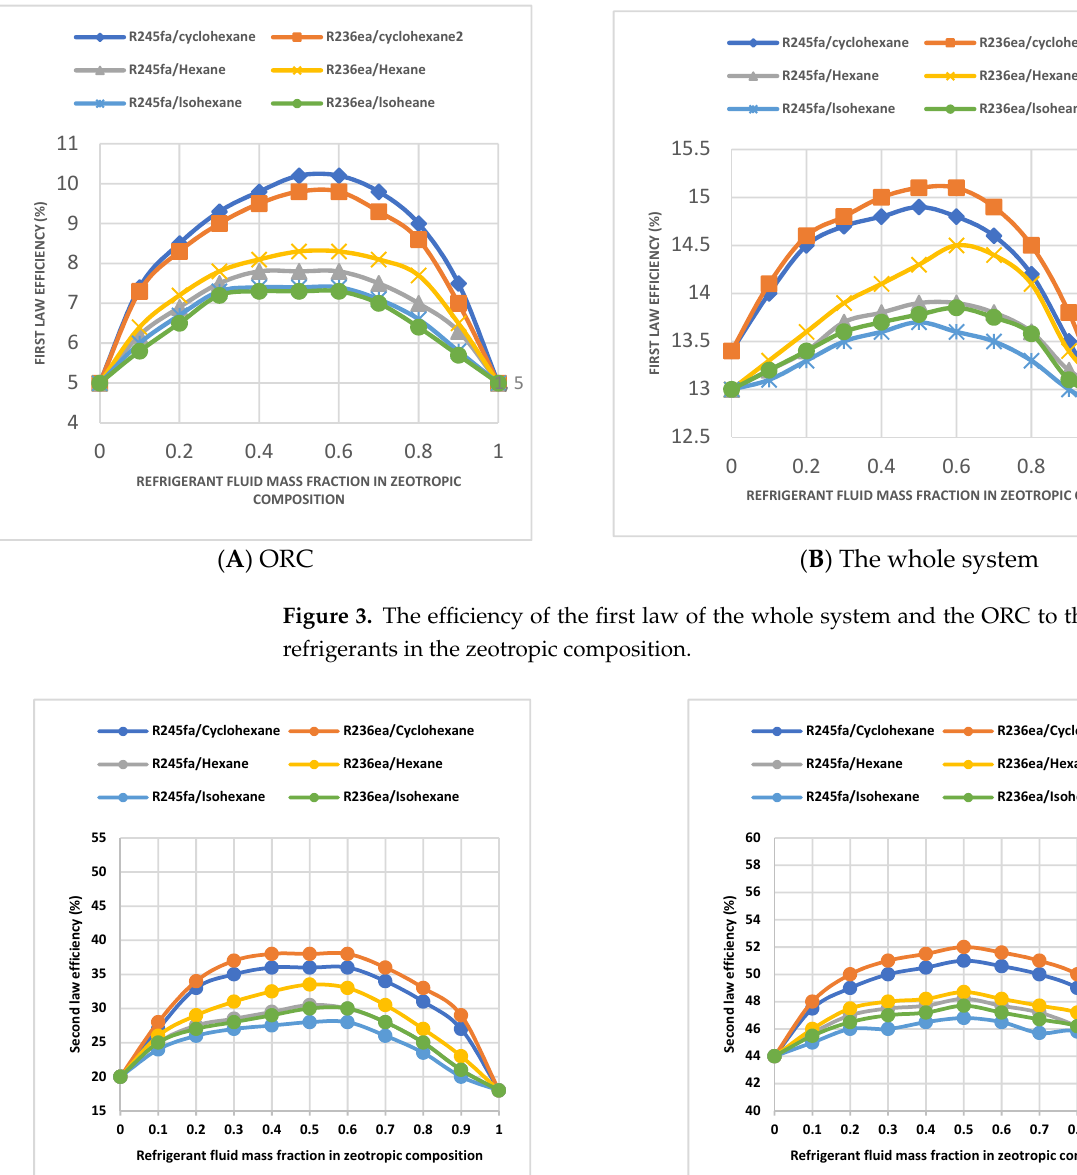
Figure 4. The efficiency of the second law of the whole system and the ORC to the mass fraction of refrigerants in the zeotropic composition.